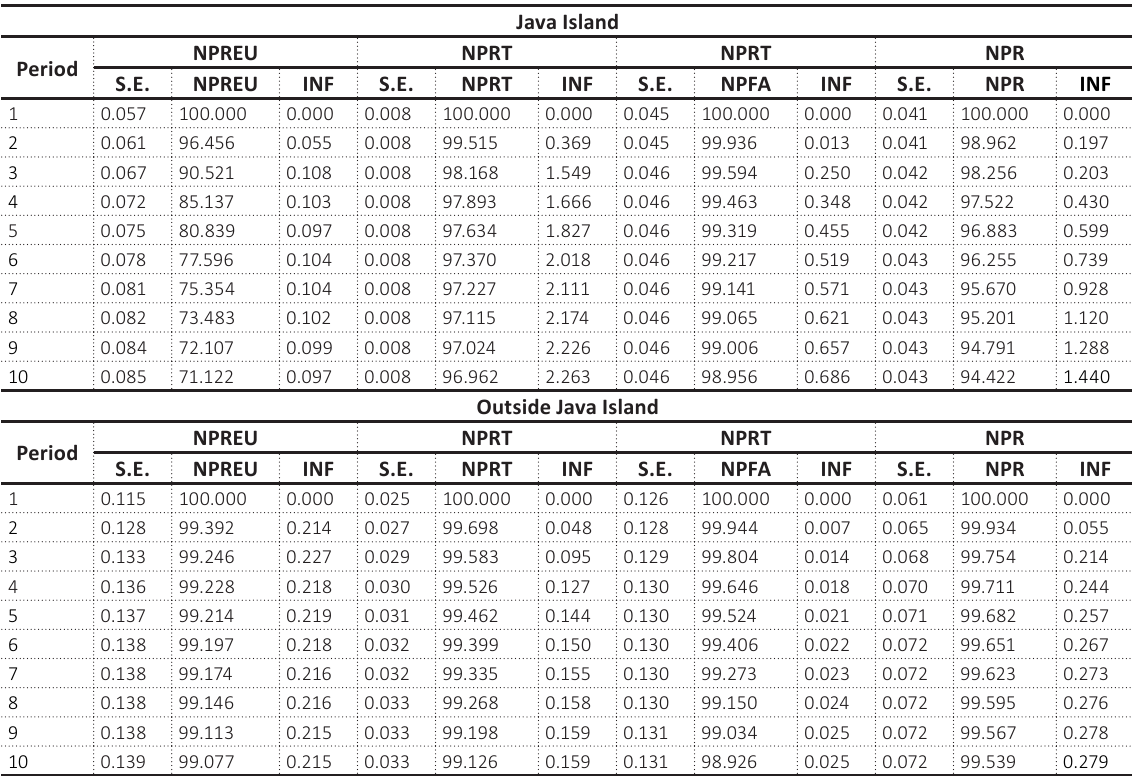
Table 2D. During the COVID-19 outbreak